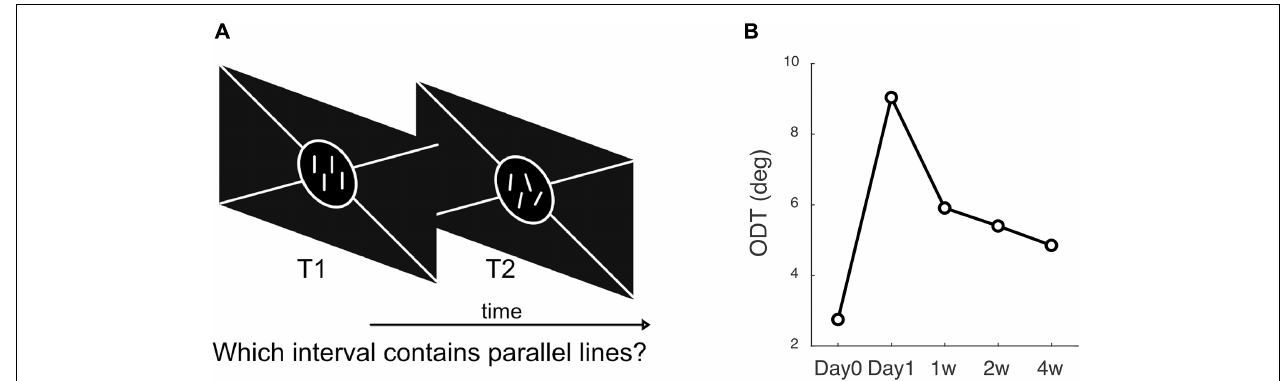
FIGURE 2 | Methods to measure ODT. (A) The subject’s task was to answer which interval contains the parallel lines, 1st or 2nd. (B) A subject’s ODT measured at each follow-up visit.